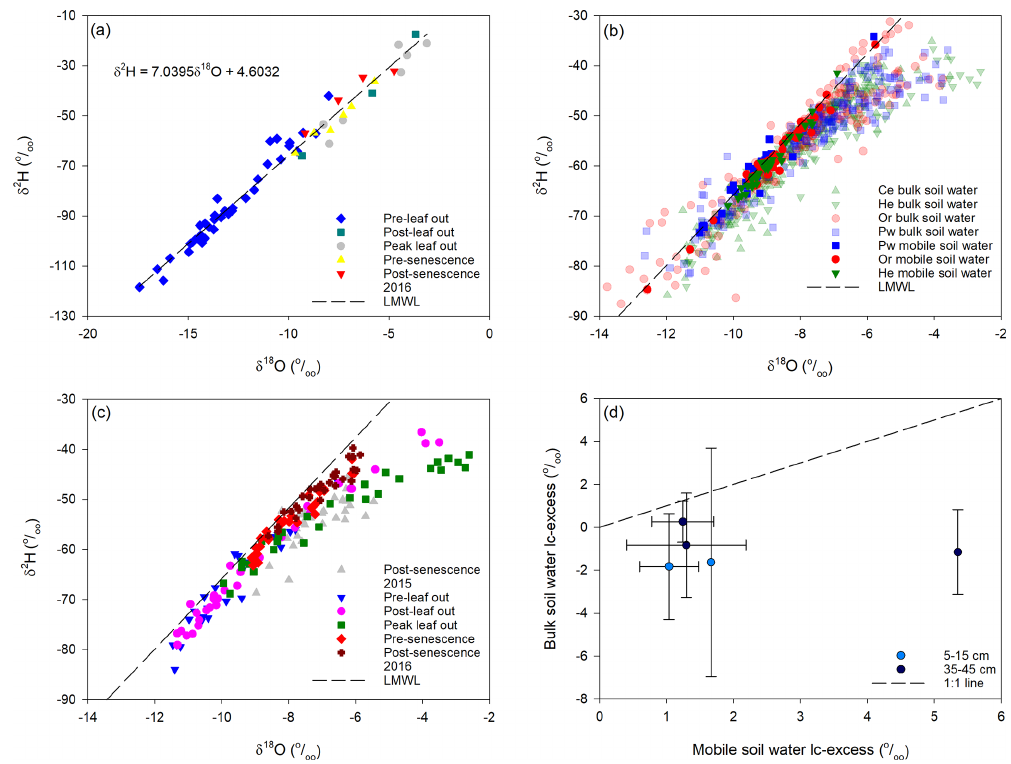
Figure 2. Isotopic composition of snowmelt and rainfall for the various sampling periods for xylem water and bulk soil water and the esti- mated local meteoric water line (LMWL) (a) ; isotopic composition of bulk soil water and mobile soil water for the sampled tree species (b) ; isotopic composition of bulk soil water for each sampling period beneath He trees (c) ; mean bulk soil water lc-excess at 5–15 and 35–45cm depths ( ± 1SD) vs. mobile soil water lc-excess at 10 and 40cm depths, respectively, on or close to the same date (d)